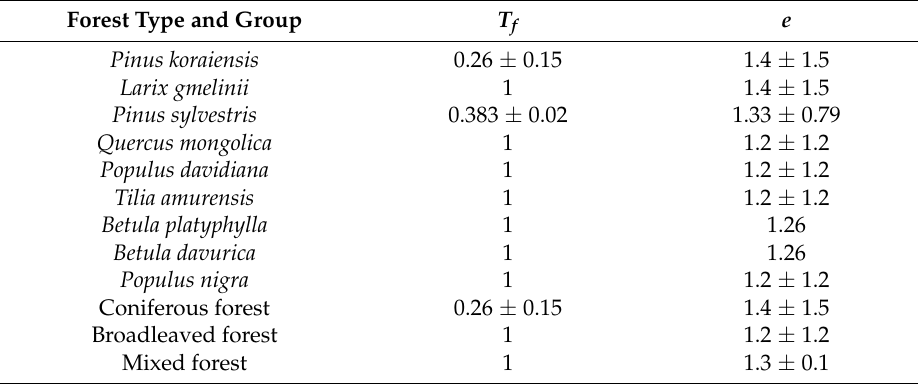
Table 4. New fine root carbon to new leaf carbon allocation values and foliage turnover rates for 12 forest types and groups.